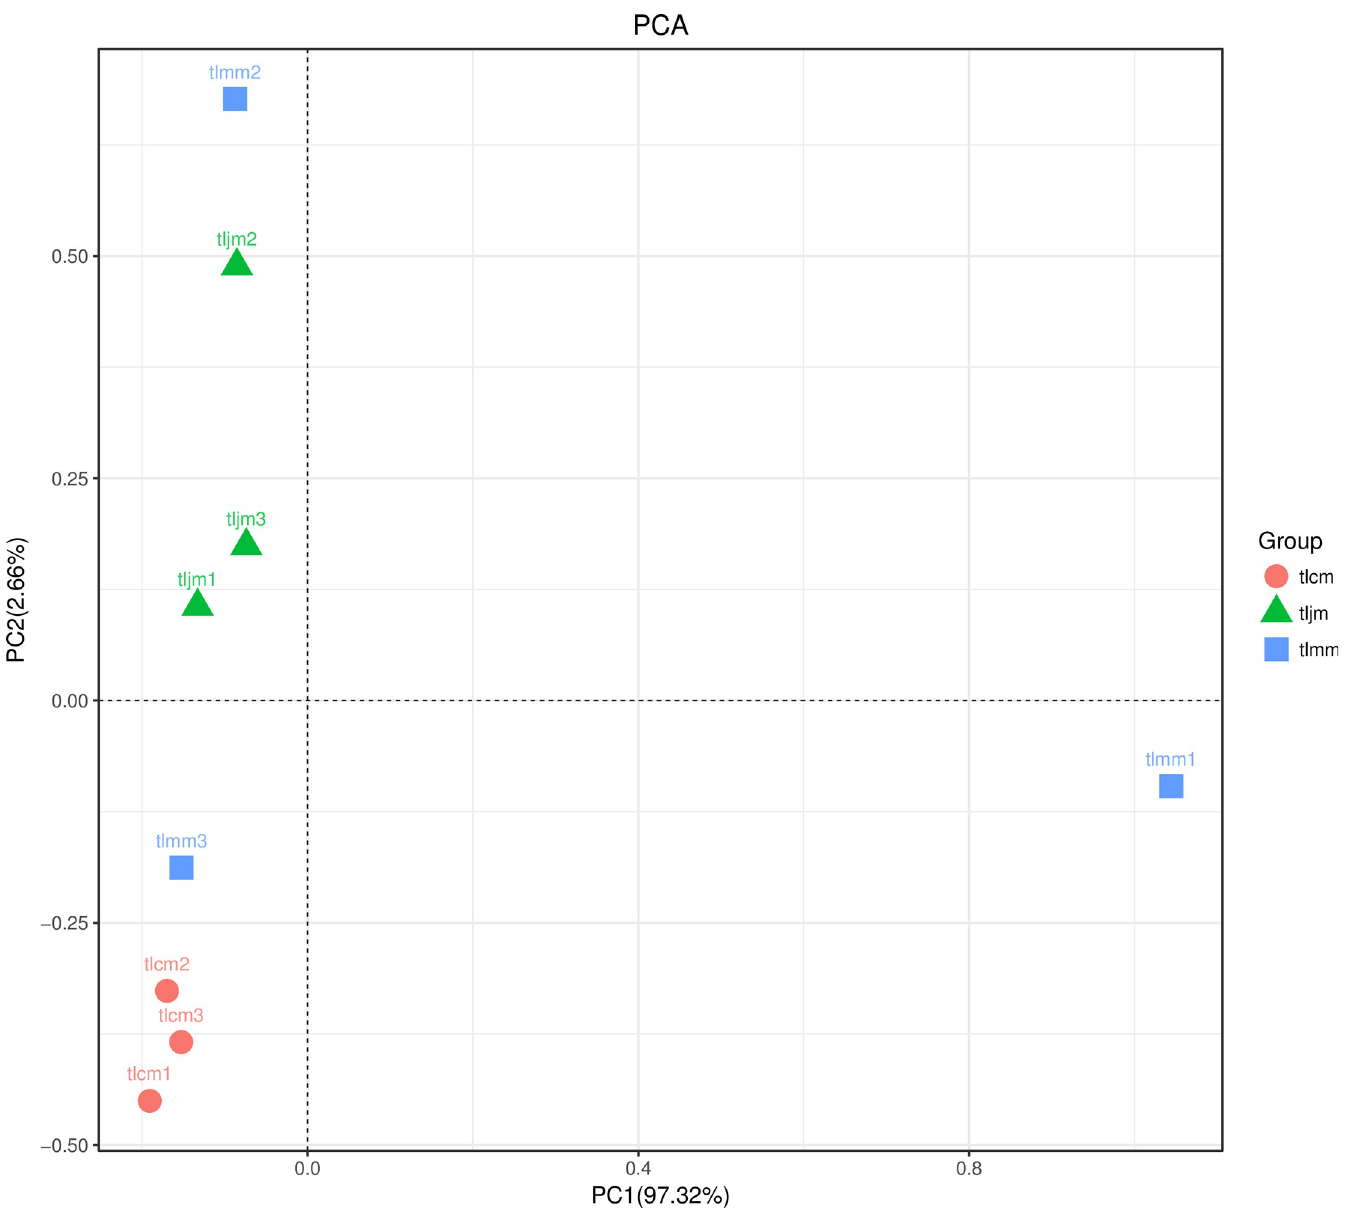
Fig 4. PCA analysis of the bacterial lactase gene from intestinal mucosa. Each point represents a sample, and different color points belong to different groups. The closer the two points are, the smaller the difference of the lactase-producing bacterial community structure between the two samples is. tlcm, tlmm and tljm were the healthy control group, diarrhea model group and D . hansenii treatment group